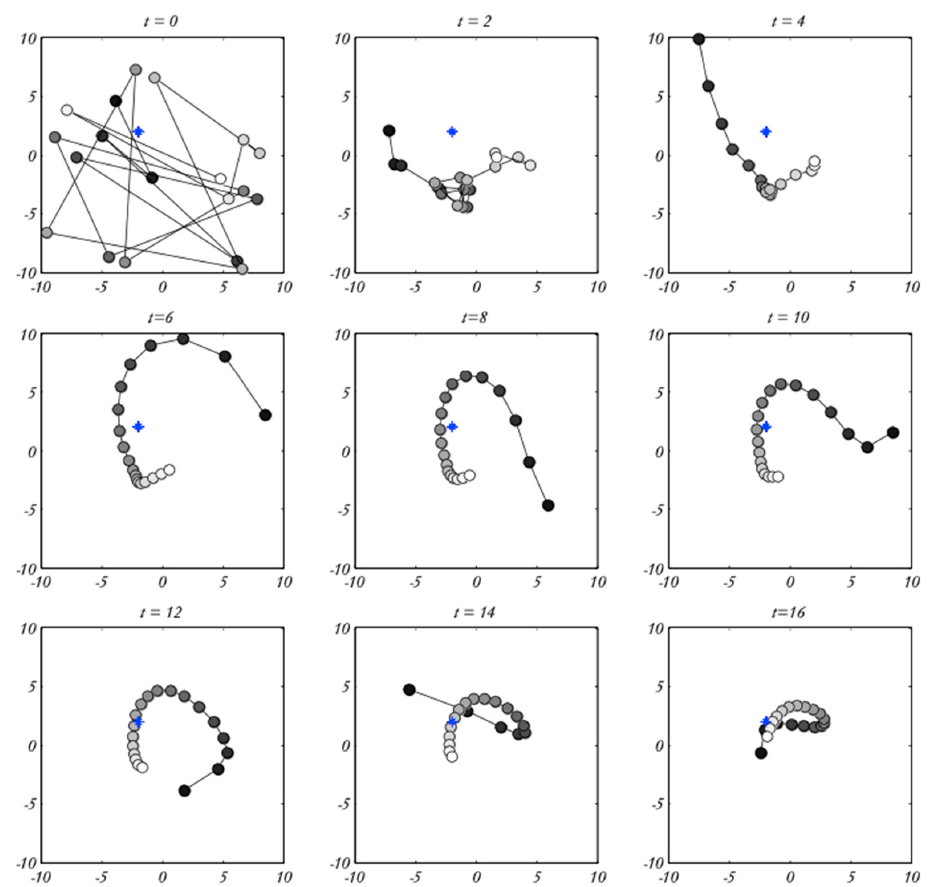
Figure 3. Illustration of Salp Swarm Chain Movement around a Stationary Source of Food in a 2D Space [28].